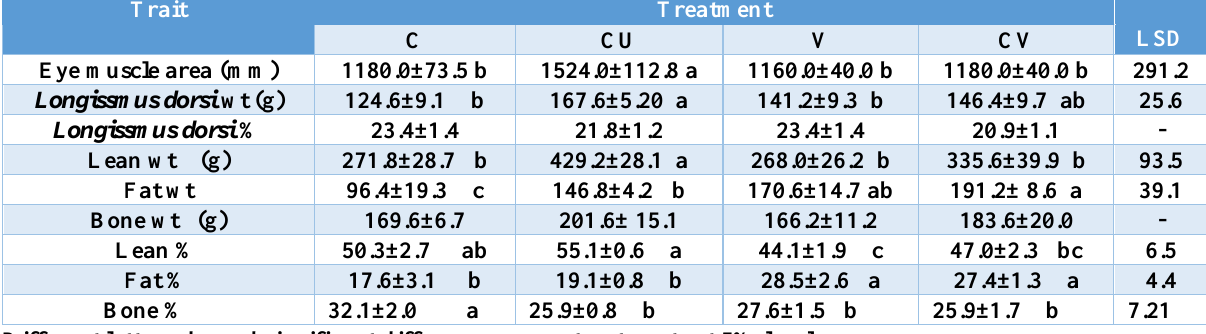
Different letters showed significant difference among treatments at 5%